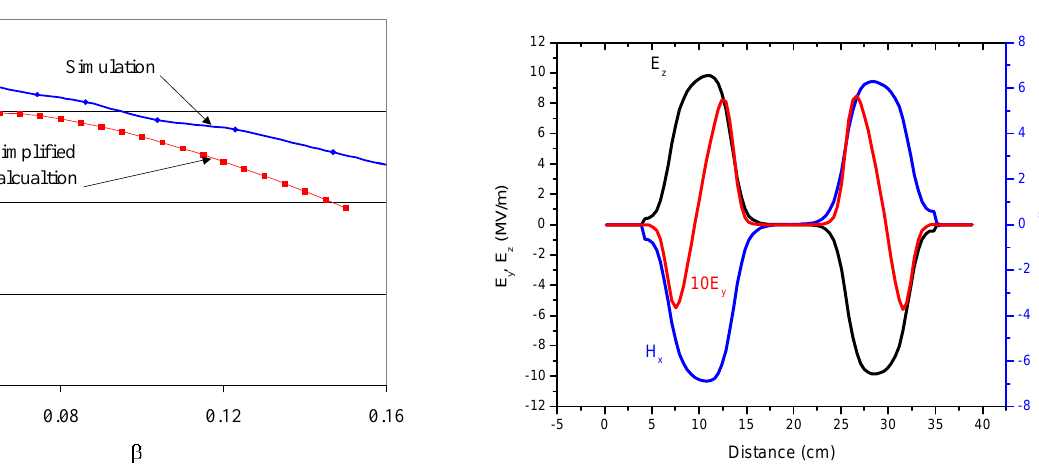
FIG. 9. (Color) Field distribution along the axis of the 115 MHz QWR modified to correct beam steering. For clarity, the mag- netic field is shown with opposite sign with respect to the electric field. The amplitude of E y is multiplied by a factor of